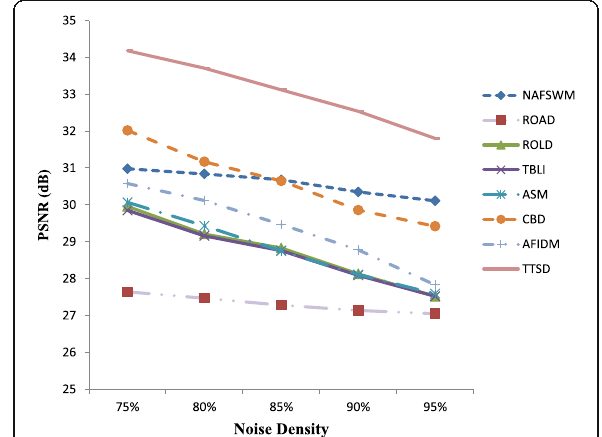
Fig. 9 Graph of comparison of PSNR of different methods for TID2008 database at 80% noise density